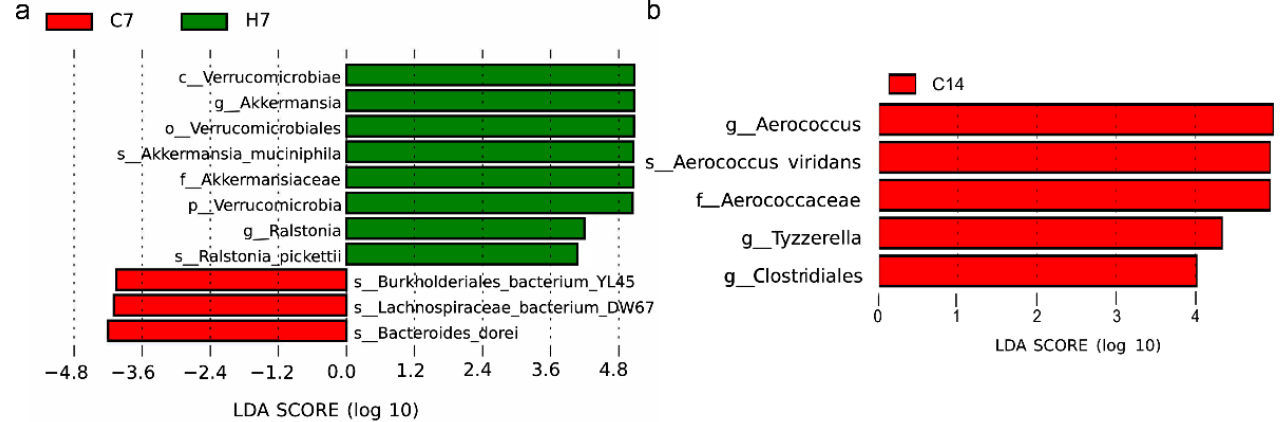
Figure 4. LEfSe of taxa with significantly different abundances in different groups. ( a ) C7 vs. H7; ( b ) C14 vs. H14.